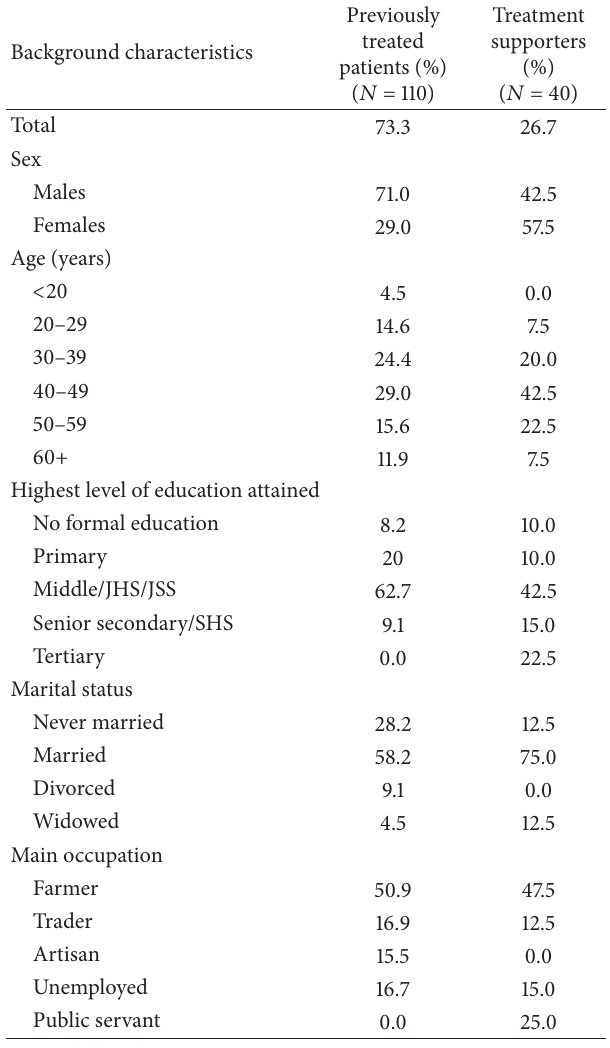
Table 1: Background characteristics of